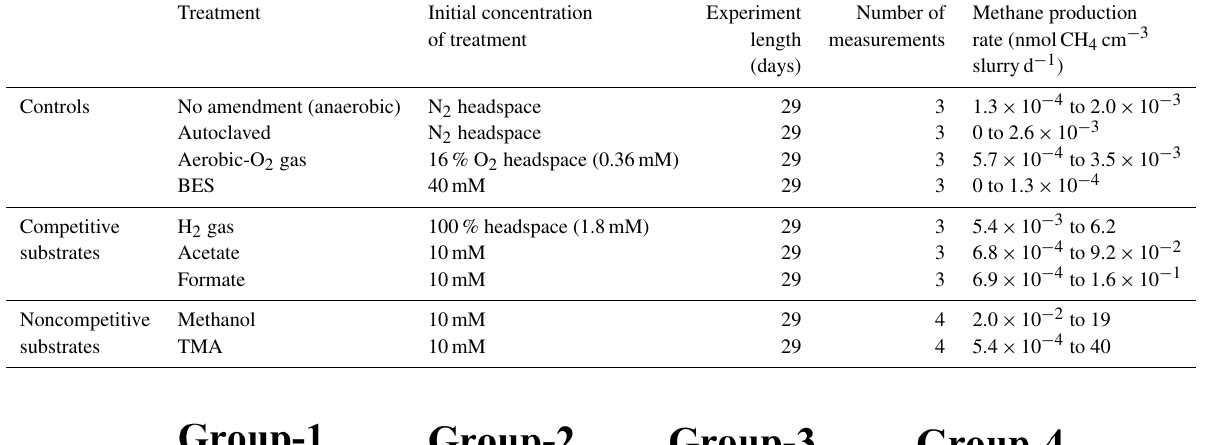
Table 1. Experimental conditions and sampling time intervals for methane headspace concentration analyses of sediment slurry incubations. Treatment